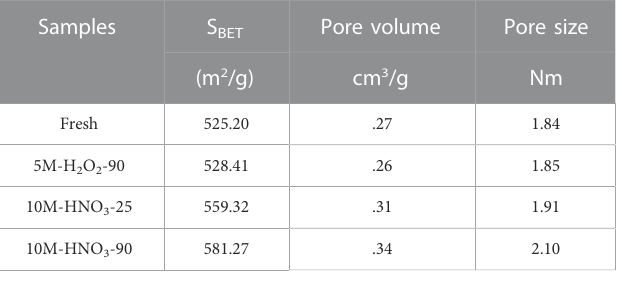
TABLE 2 Surface area and pore features of the typical activated carbon samples.